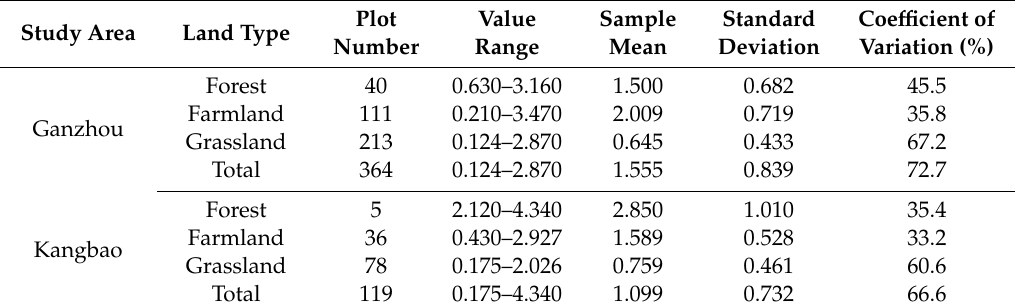
Table 1. Land type area according to the forest management inventory (FMI) and the measurements of the leaf area index (LAI) for all of the sample